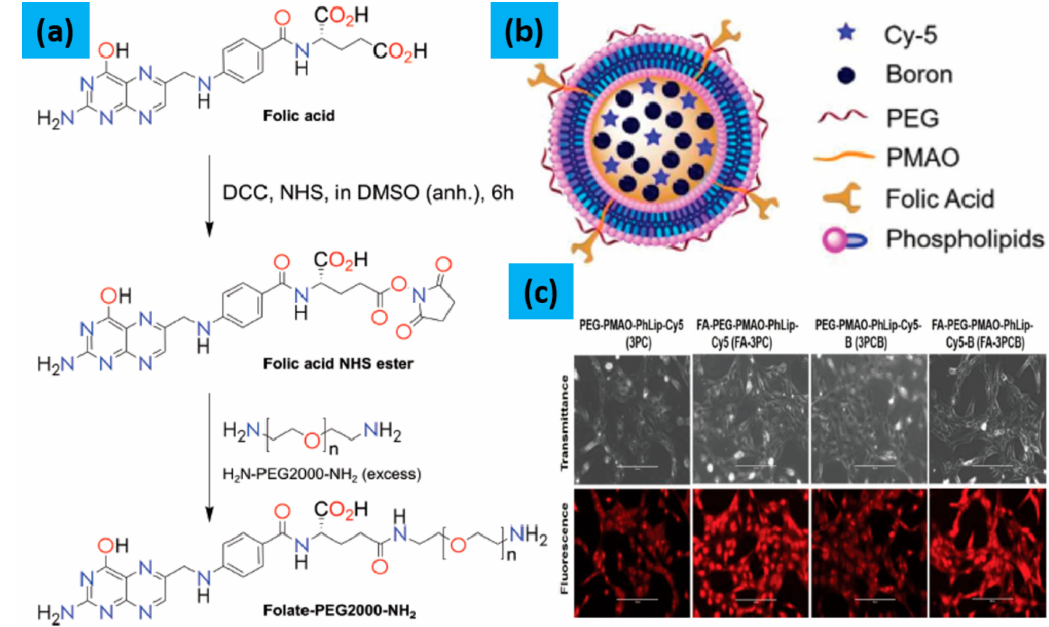
Figure 4. Schematic image of boron encapsulated liposome (Adopted from Ref.